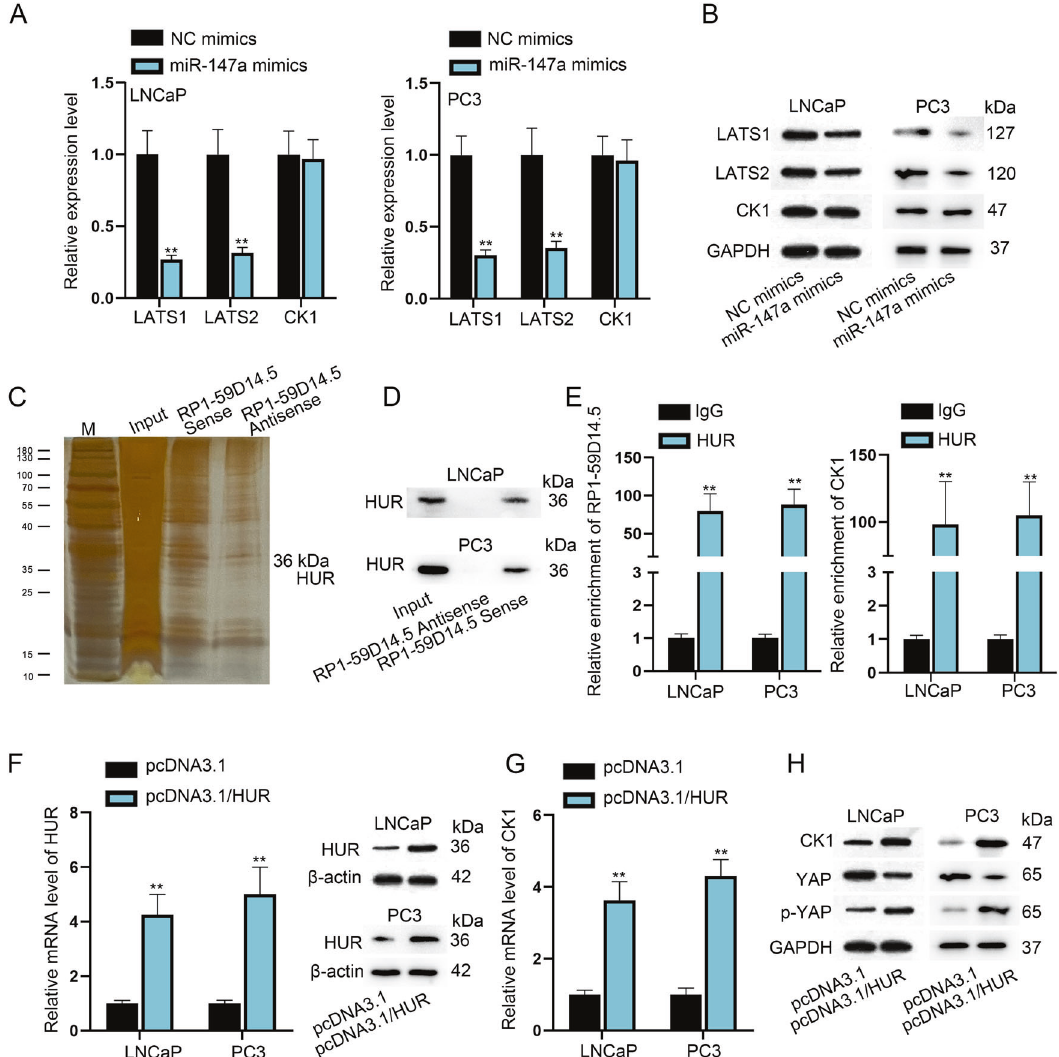
Fig. 5 RP1-59D14.5 recruits HUR to promote CK1 expression and activates the Hippo pathway in PCa cells. A , B RT-qPCR and western blot detected the mRNA and protein levels of LATS1/2 and CK1. C RNA pull down assays analyzed the proteins combined with RP1-59D14.5. M: marker. HuR: 36 kDa. D RNA pulldown assay analyzed the interaction between HUR and RP1-59D14.5. E RIP assays detected the enrichment of RP1-59D14.5 and CK1. F RT-qPCR and western blot detected the levels of HUR with HUR overexpression. β -actin serves as an internal control. G , H RT-qPCR and western blot detected mRNA level of CK1 and protein levels of CK1, YAP and p-YAP in HUR-overexpressed cells. ** P <